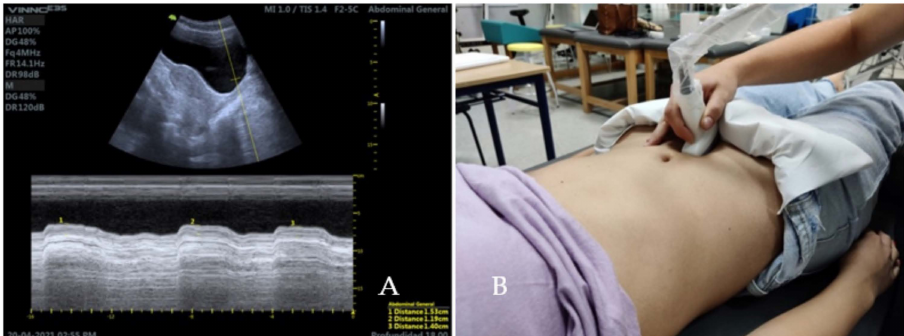
Figure 5. Ultrasound imaging and transabdominal ultrasound of the PF musculature (sagittal plane). ( A ) corresponds to the PF excursion. ( B ) represent the transducer position in a sagittal transabdominal ultrasound imaging of the bladder.